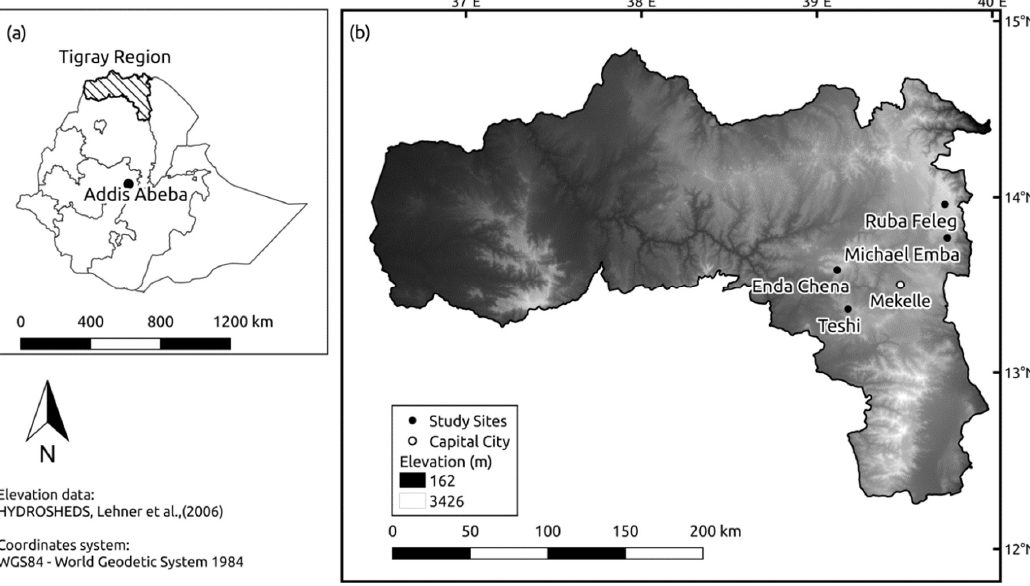
Figure 1. Study area: ( a ) Location of Tigray Region in Ethiopia; ( b ) location of study sites within Tigray Region. Elevation data from [47].